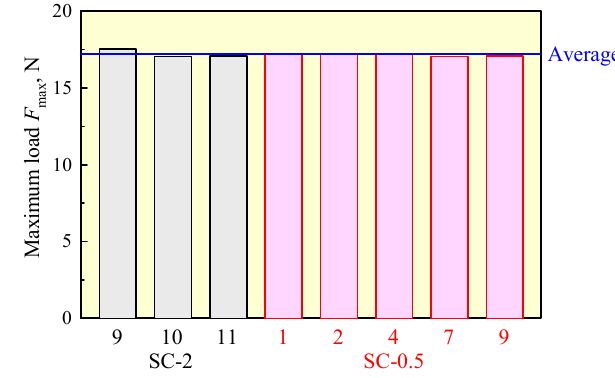
Figure 11. The maximum load, F max , for the eight specimens failed by fracture of copper wire.